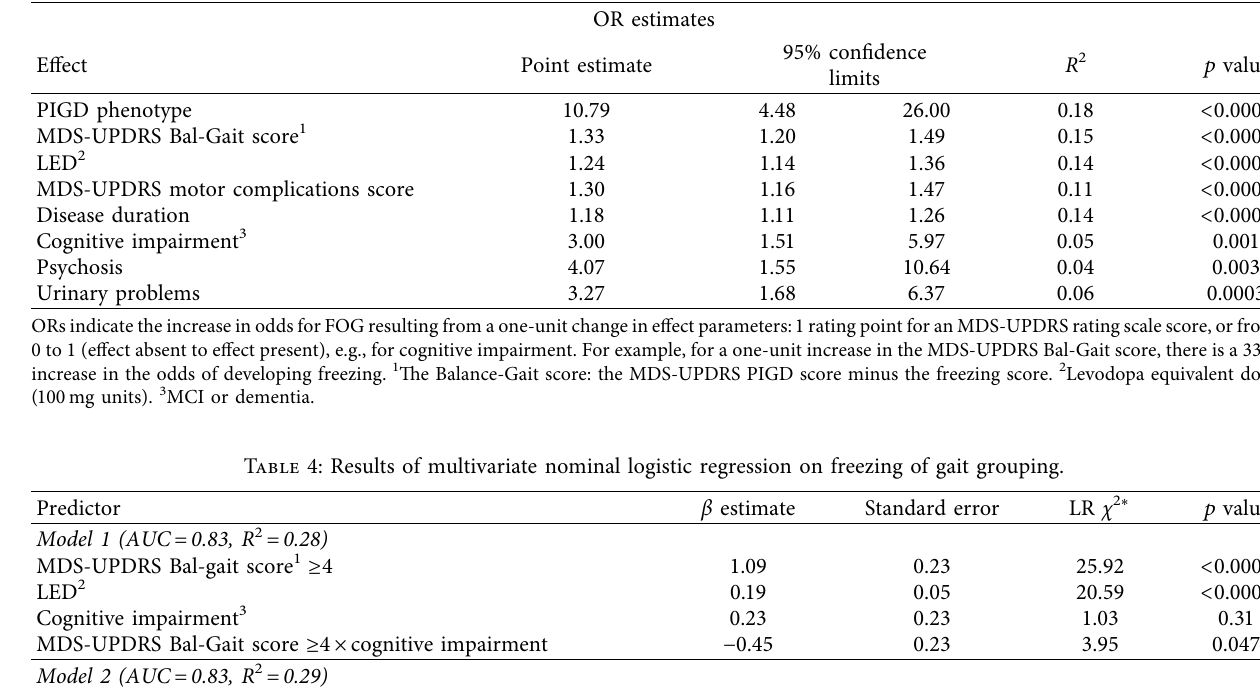
Table 3: Clinical variables with high predictive accuracy for freezing of gait using univariate logistic regression analysis.